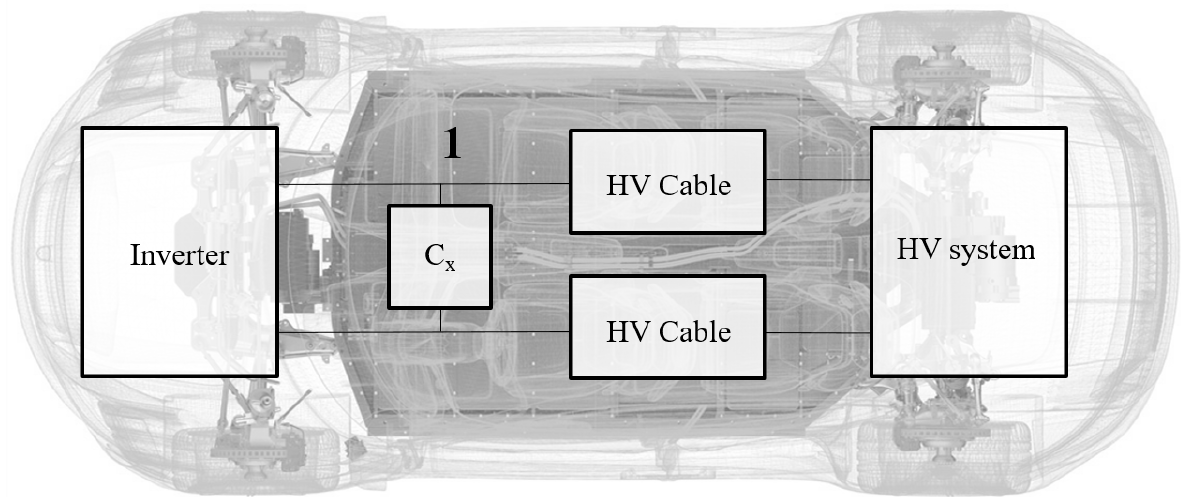
Figure 3. Subsystems for the examination of the shield currents. The inverter and current emission model is discussed in Section 6. The system impedance model is discussed in [7,19]. The DC-link capacitor is modelled as an RC element